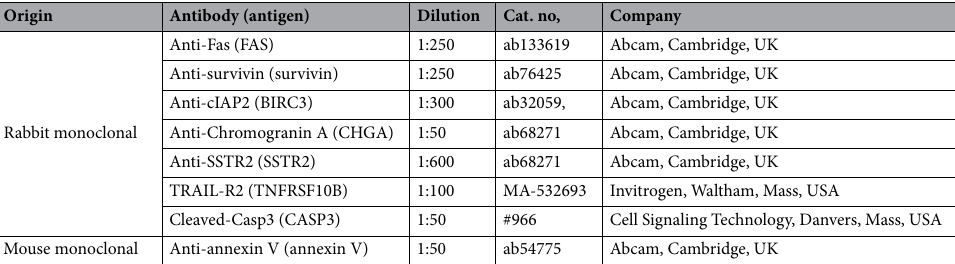
Origin Antibody (antigen) Dilution Cat. no,